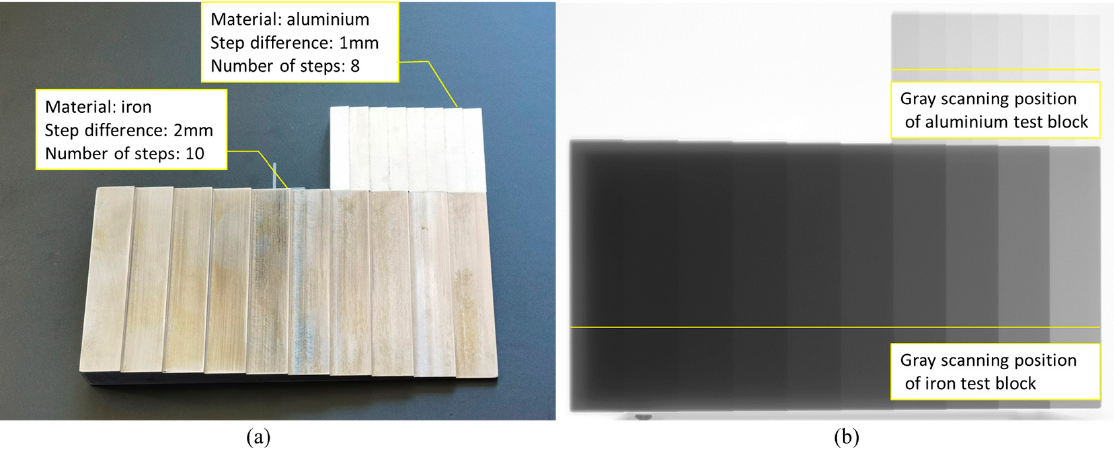
Figure 3. ( a ) Step test block used in imaging experiment and ( b ) obtaining position of gray curve of X-ray image of test block.